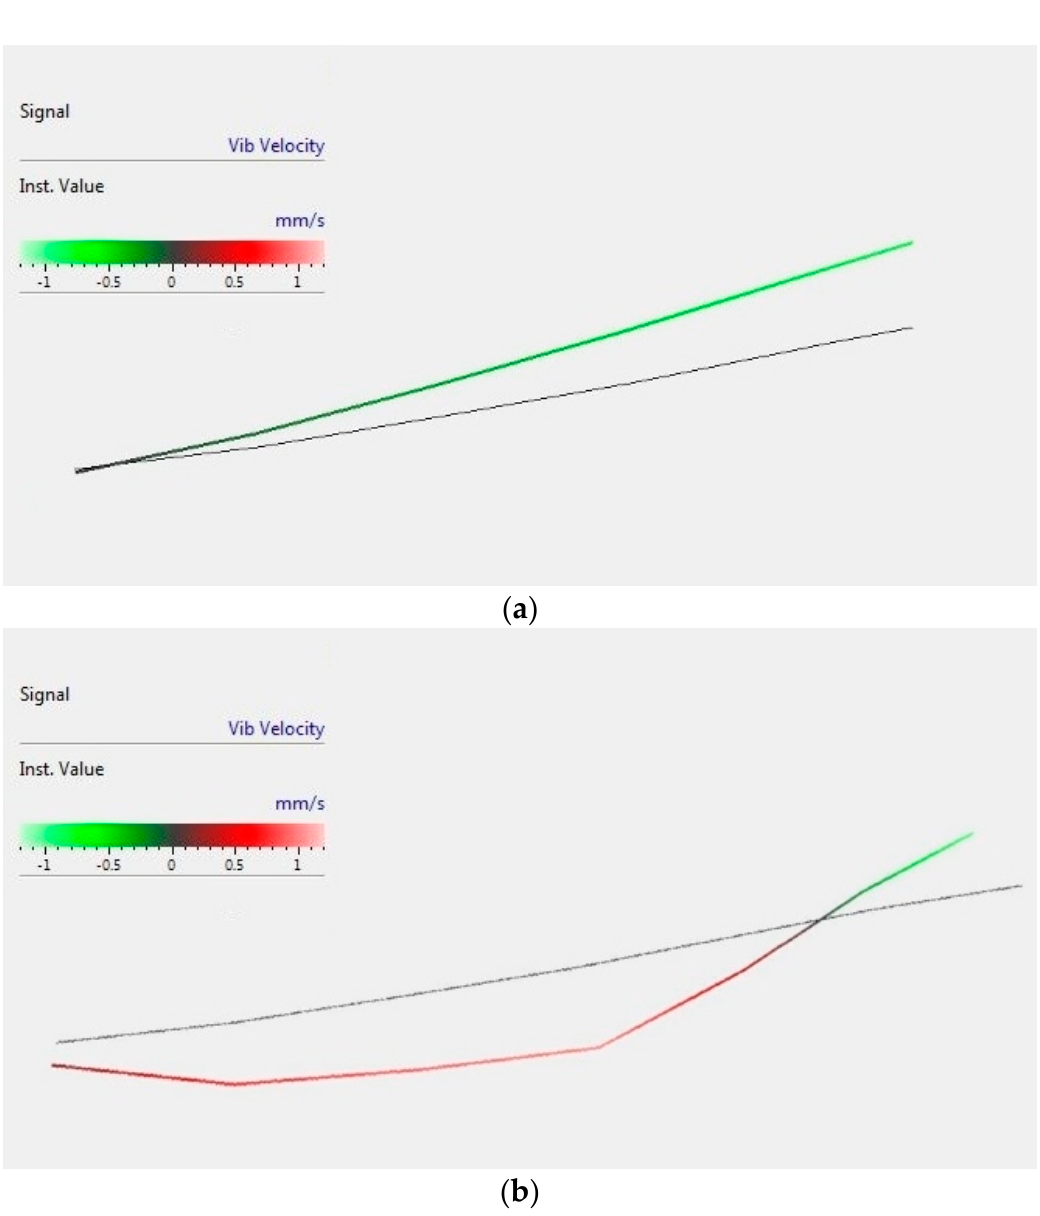
Figure 7. ( a ) First and ( b ) second bending mode shapes obtained with the laser vibrometer.